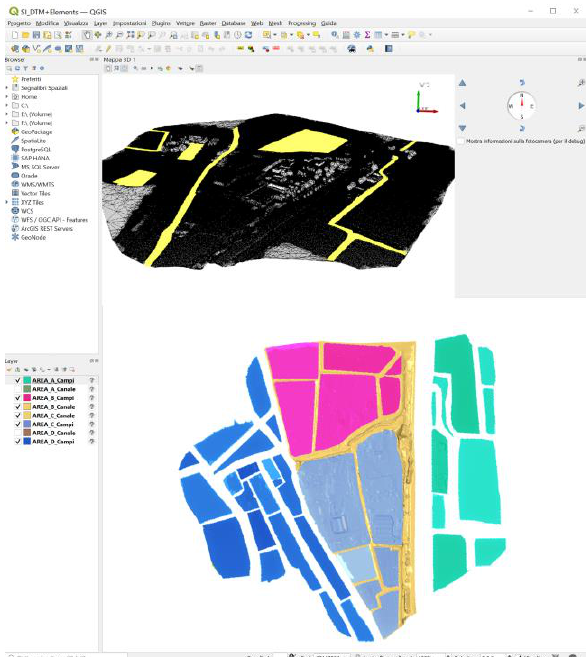
Figure 7 . Images of models and census integrated on the open- source information system platform –